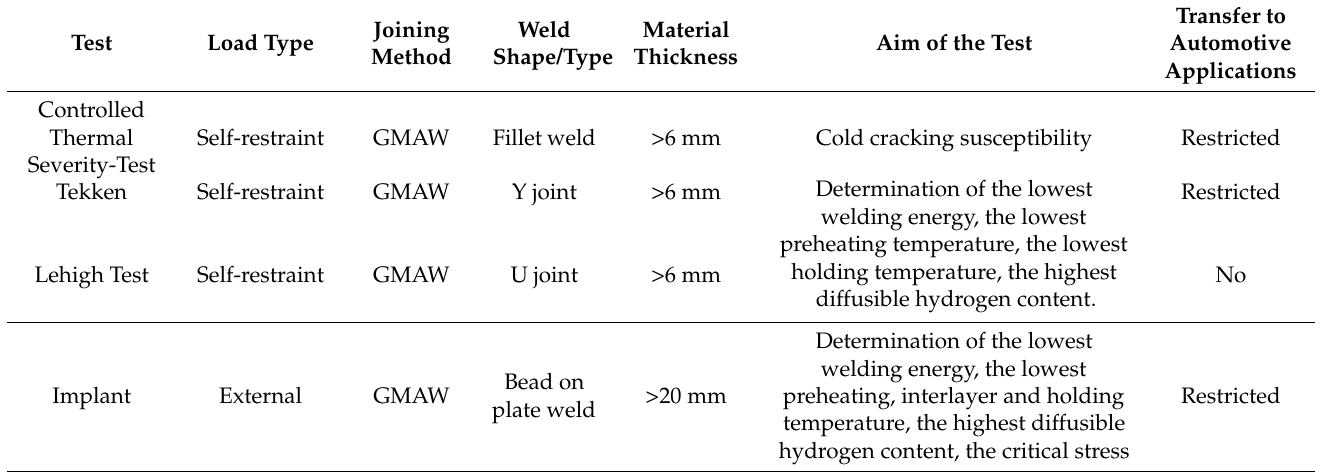
Table 1. Overview of standardized cold cracking tests from EN ISO 17642